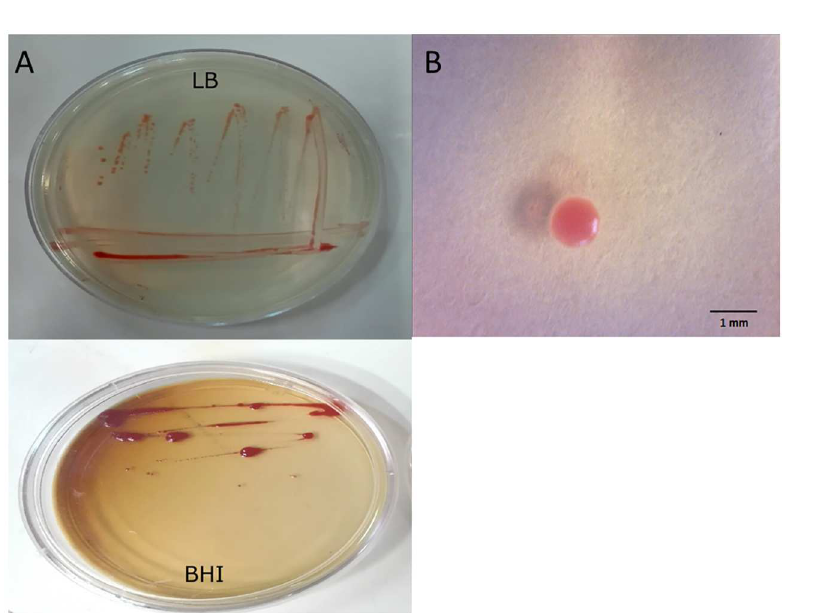
Fig 3. Morphology and colour of Dietzia sp. RNV-4. (A) Pigment expression after 48-h incubationat 32˚C on Brain-Heart Infusion Agar (BHI) and Luria-Bertani agar (LB) media (B) Picture of a colony in LB agar obtained with a digital microscope